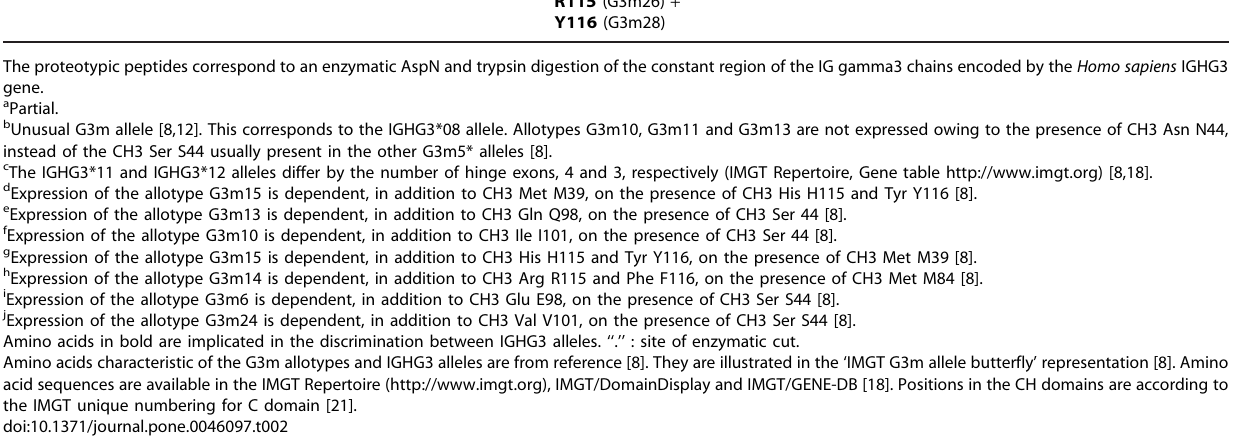
Theoretical proteotypic